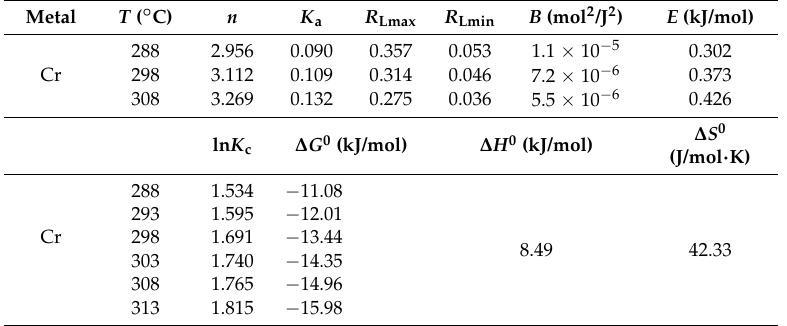
Table 3. Parameters for nature judgment and thermodynamics of Cr adsorption on Typha angustifolia activated